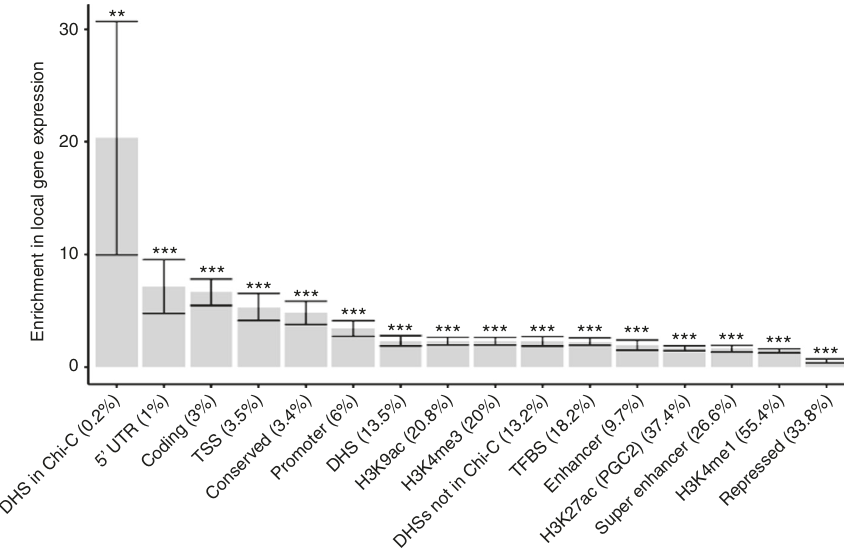
Fig. 1 Open chromatin sites (DHSs) within adipocyte promoter CHi-C chromosomal interactions show signi fi cant enrichment in cis expression. Enrichments in cis expression with error bars for different categories using LD score regression analysis (see Methods). For the horizontal axis labels, the value in parentheses shows the percentage of SNPs contained within the respective annotation category that contributed to the enrichment calculation. For the signi fi cance threshold after Bonferroni correction above each bar, * indicates a p -value < 0.05; **, a p -value < 0.001; and ***, a p -value < 0.0001, respectively. The p -values were estimated based on Z scores calculated from the normal distribution. Error bars represent jackknife standard errors